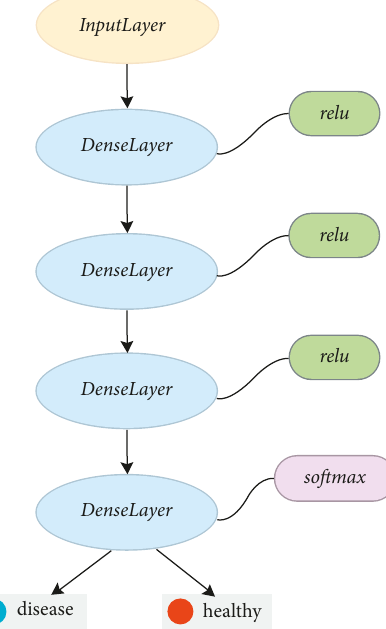
Figure 1: deep learning model